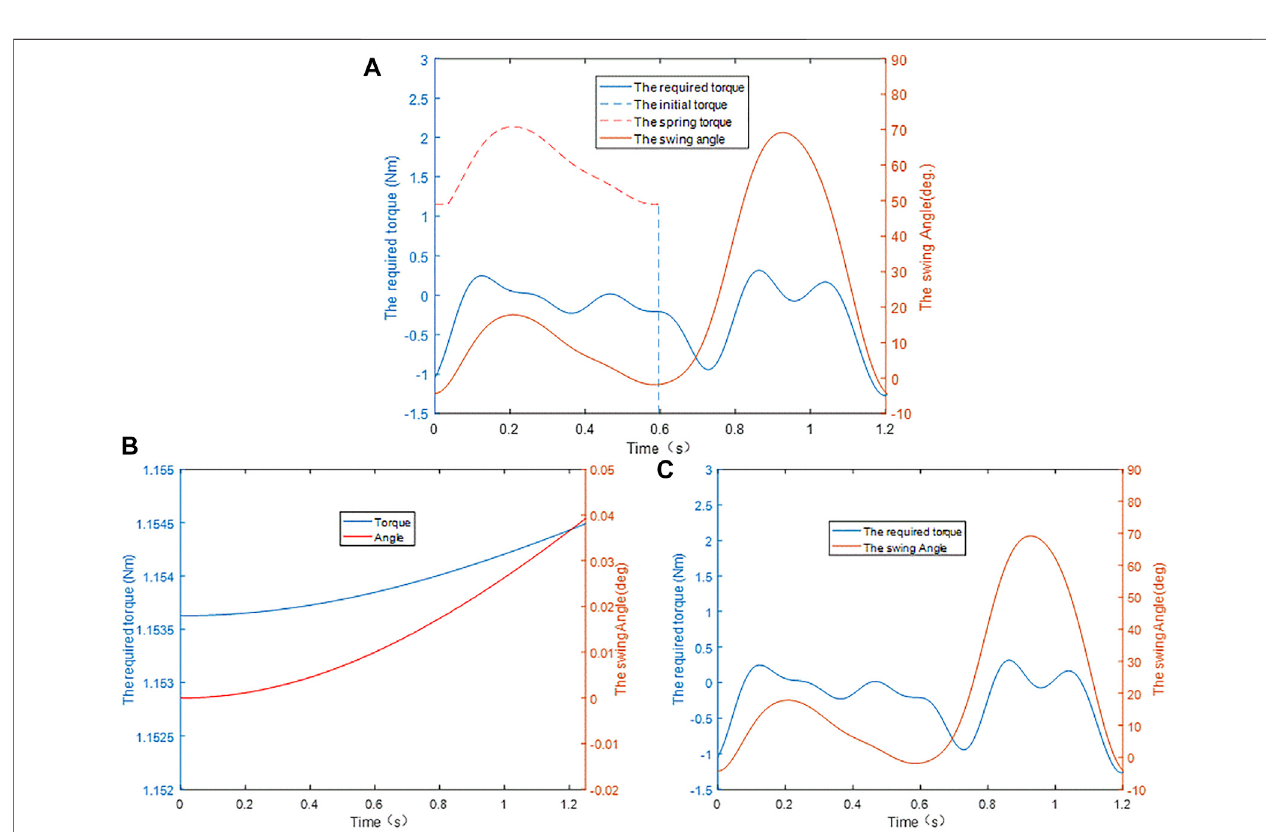
FIGURE 7 | (A) Parameter design of the knee torsion spring. (B) Driving torque of the cam. (C) Driving torque of the exoskeleton calf.